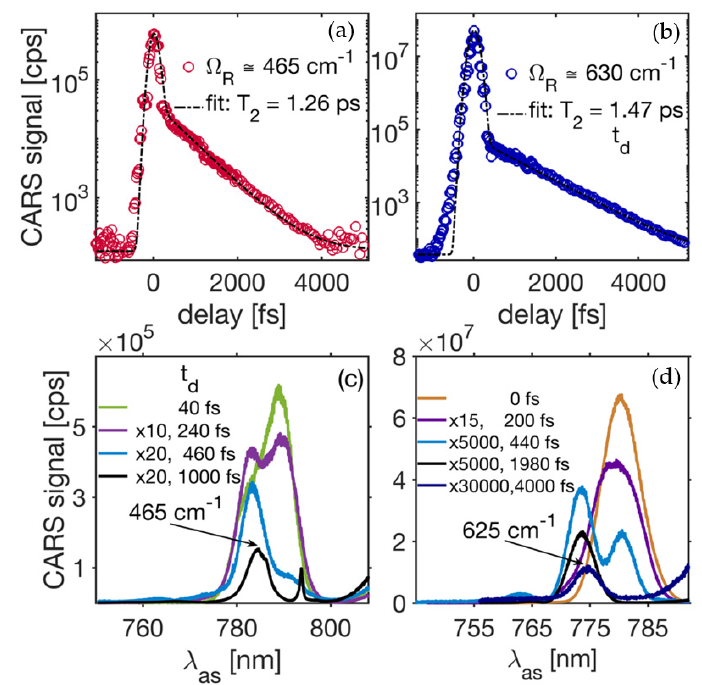
Figure 2. CARS transients obtained from cubic BaSnO 3 crystal while favoring LO 2 ( a ) and LO 3 ( b ) phonon mode excitations. For these cases, the OPO 1 central wavelength was fixed at 1015 nm, and the OPO 2 wavelengths were tuned to ~1065 nm and ~1073 nm, correspondingly. The CARS signals have been detected and monitored at the anti-Stokes wavelengths indicated by arrows on the spectral data, shown in parts ( c , d ), correspondingly. Dash-dotted lines correspond to the best fitting results using the theoretical model presented by formulas (1)–(3). The phonon decay time constant values ( T 2 ) that resulted in the best fit are indicated in the